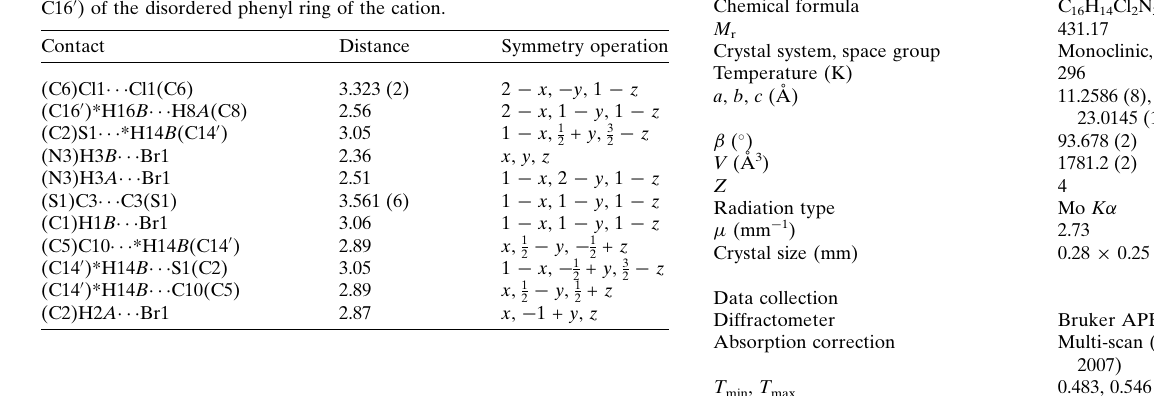
Table 4 Experimental details. Crystal data Chemical formula